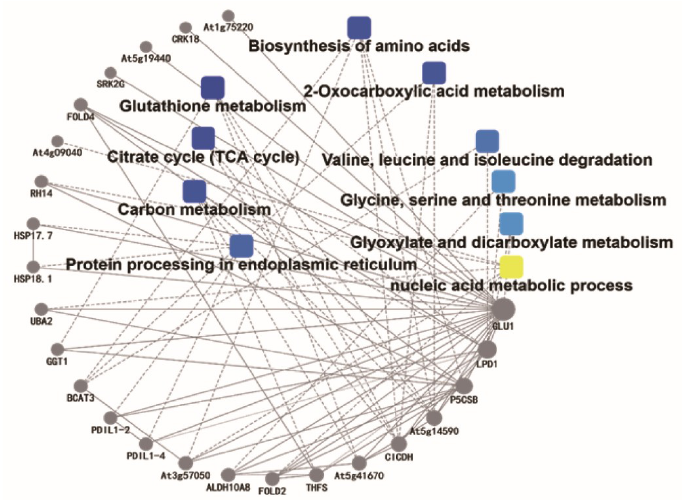
Figure 5. Protein–protein interaction (PPI) network analysis by the Search Tool for the Retrieval of Interacting Genes / Proteins (STRING) PPI network. , GO / KEGG term; , protein. Symbol color corresponds to degree of interaction.